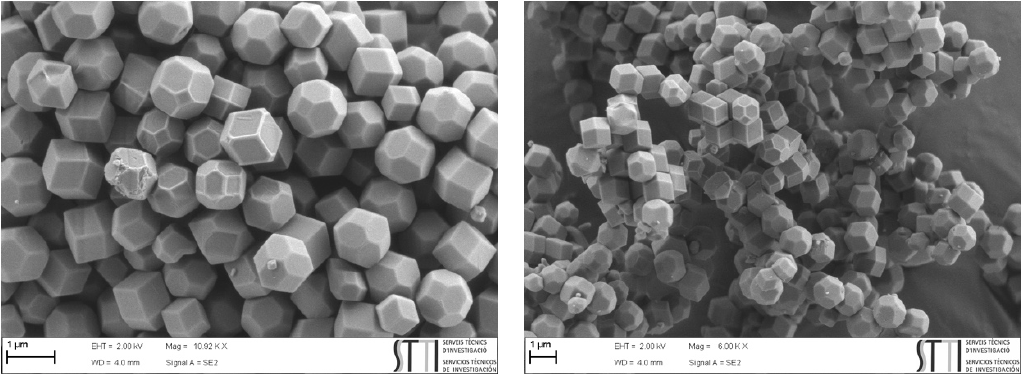
Figure 5. Secondary electron micrographs of ZIF-67.